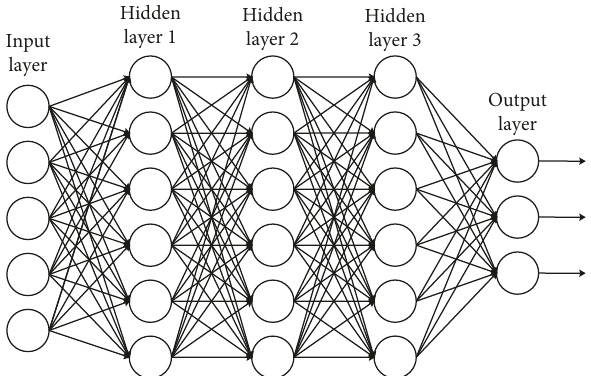
Figure 3: Deep neural network